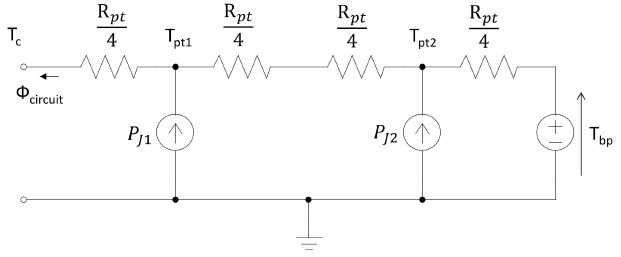
Figure 10. Thermal model of module K power terminals.